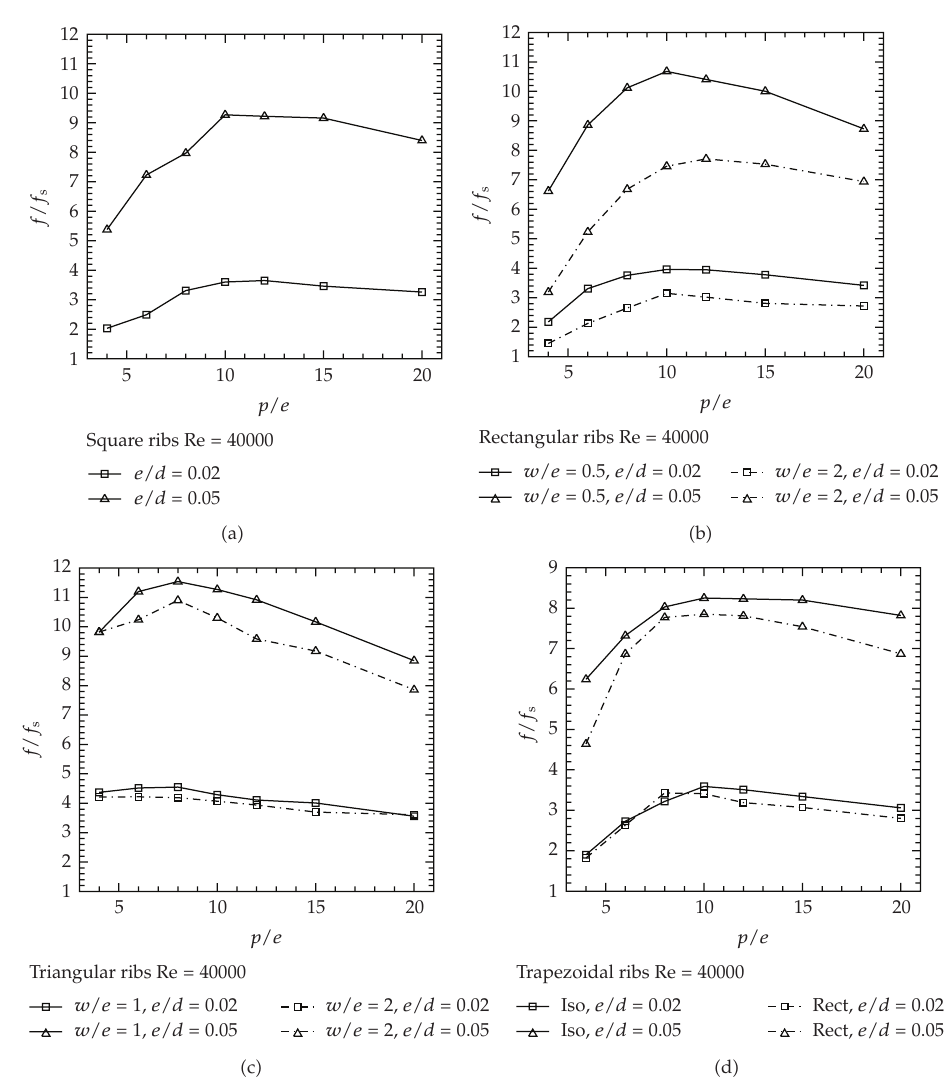
Figure 7: Friction factor profiles, referred to the smooth channel results, as a function of p/e at Re (cid:8) 40000, for e/d (cid:8) 0 . 02 and 0.05: (cid:6) a (cid:7) square-ribs, (cid:6) b (cid:7) rectangular ribs with w/e (cid:8) 0 . 5 and 2.0, (cid:6) c (cid:7) triangular ribs with w/e (cid:8) 1 . 0 and 2.0, and (cid:6) d (cid:7) isosceles and rectangular trapezoidal ribs with w/e (cid:8) 2 .